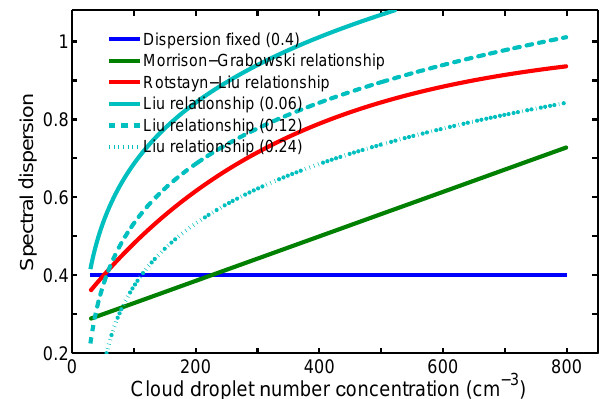
Figure 1. Variations in the relative dispersion ε as the functions of droplet concentration for ε fixed at 0.4 (blue curve), the Morrison– Grabowski relationship (green curve), the Rotstayn–Liu relation- ship (red curve), and the Liu relationship with different liquid water content L c (fixed as 0.06, 0.12, and 0.24gm − 3 for different styles of cyan